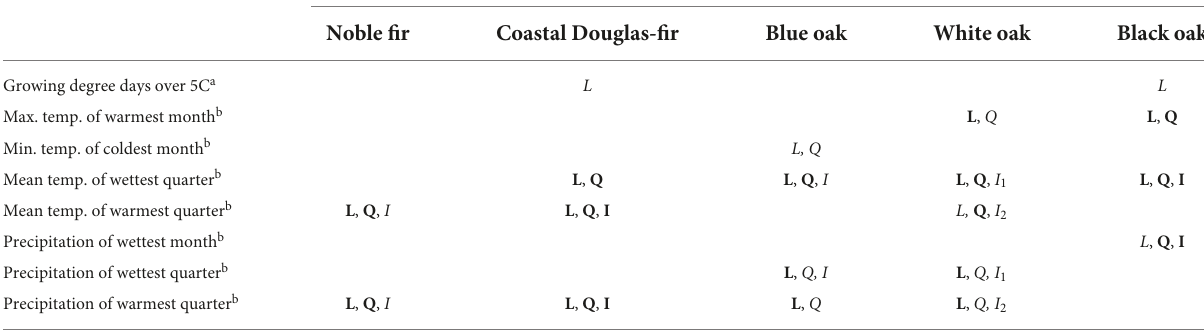
TABLE 1 Description of climate covariates and fixed-effect model forms by